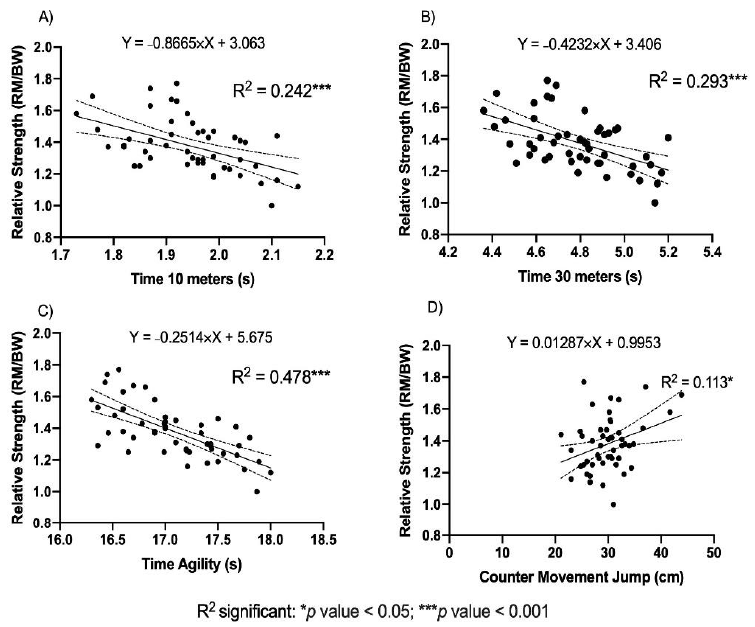
Figure 5. Simple linear regressions between relative strength and running speed ( A , B ), Agility ( C ), and CMJ ( D ).